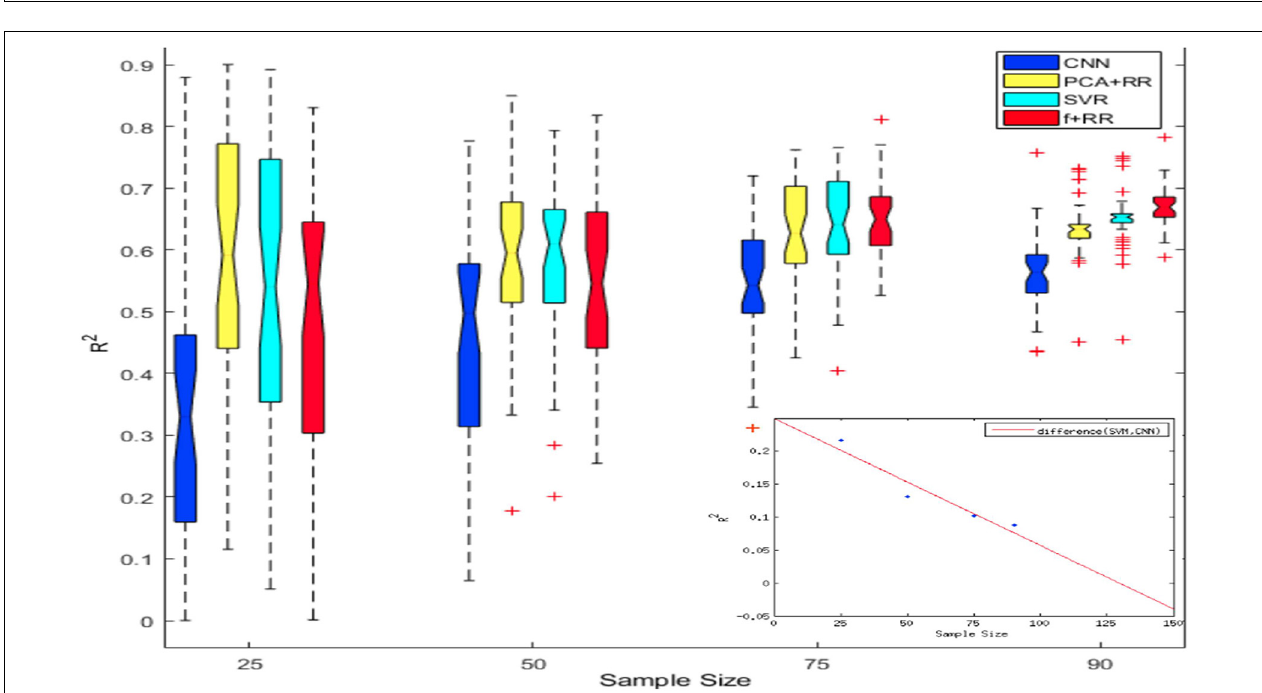
FIGURE 5 | Comparison of models’ predictive accuracy on selected subsets of patients: (A) patients with left hemisphere lesions ( N = 57), that is the population in which a language deficit is most common after stroke, and (B) patients with language deficit ( N = 29) as attested by a score < 0.